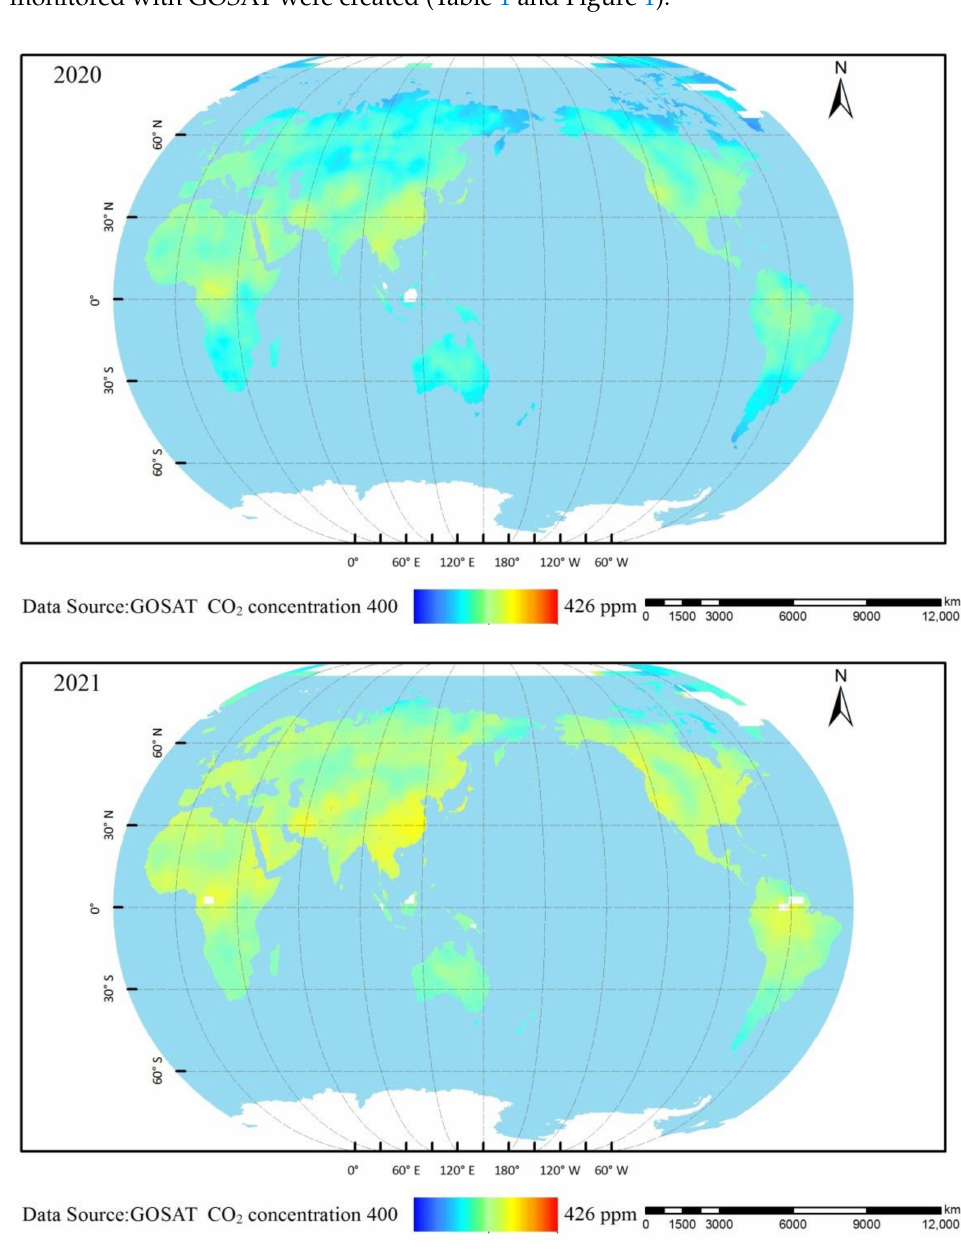
Figure 1. Map of global annual average CO 2 concentrations in 2020 and